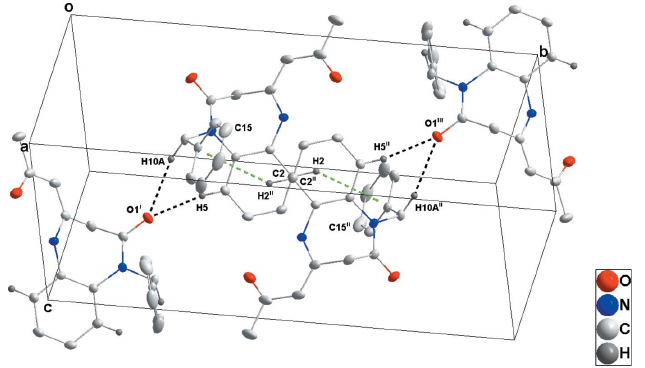
Figure 2 Details of the intermolecular C—H (cid:2)(cid:2)(cid:2) O hydrogen bonding (black dashed lines) and the C—H (cid:2)(cid:2)(cid:2) (cid:2) (ring) interactions (green dashed lines). [Symmetry codes: (i) x + 1 , (cid:5) y + 1 , z + 1 ; (ii) (cid:5) x + 1, (cid:5) y + 1, (cid:5) z + 1; 2 2 2 (iii) (cid:5) x + 1 , y + 1 , (cid:5) z + 1 .] 2 2 2